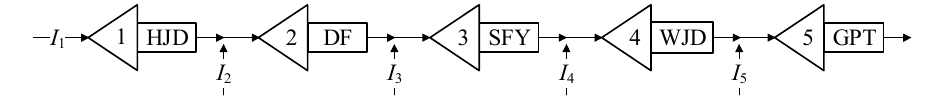
Figure 11. Topological structure of the multi-reservoir system in the Wu River. Table 8. Detailed data of the five reservoirs in the Wu River.